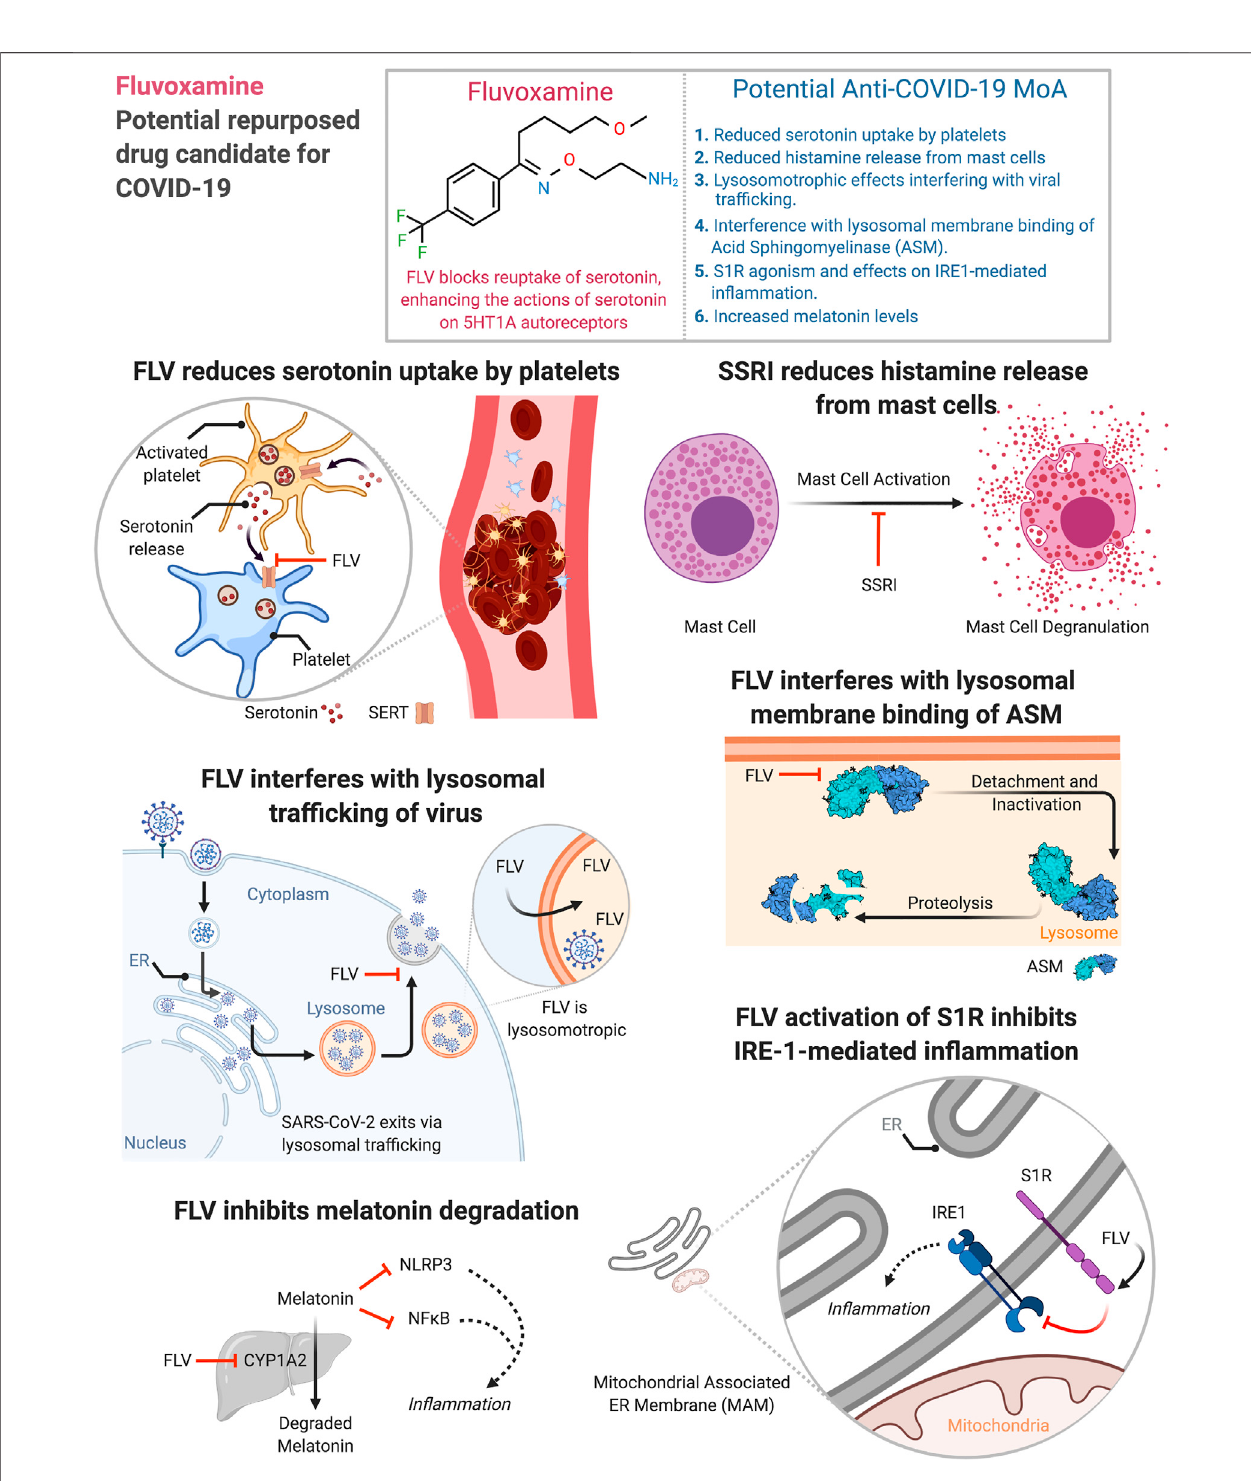
FIGURE 1 | Potential anti-COVID-19 mechanisms of action of fl uvoxamine. Figure created using Biorender.